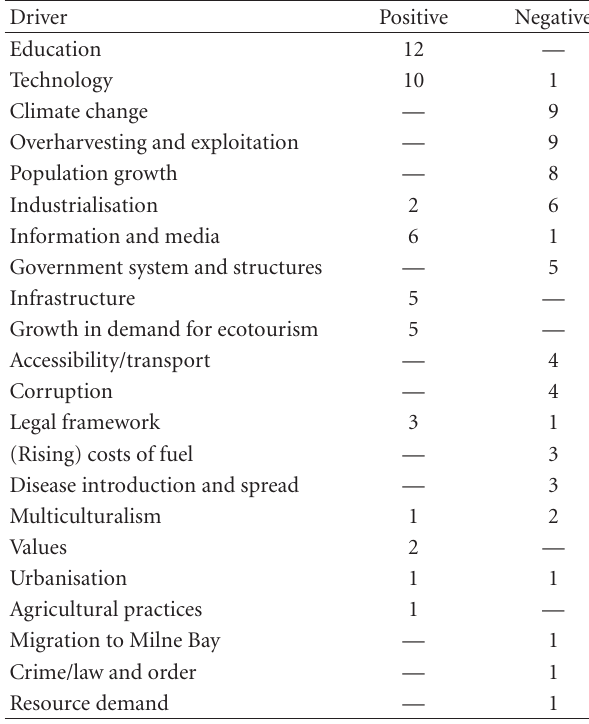
Table 1: Drivers of change for Milne Bay’s ecotourism industry, from most to least frequently mentioned by participants as a negative or positive